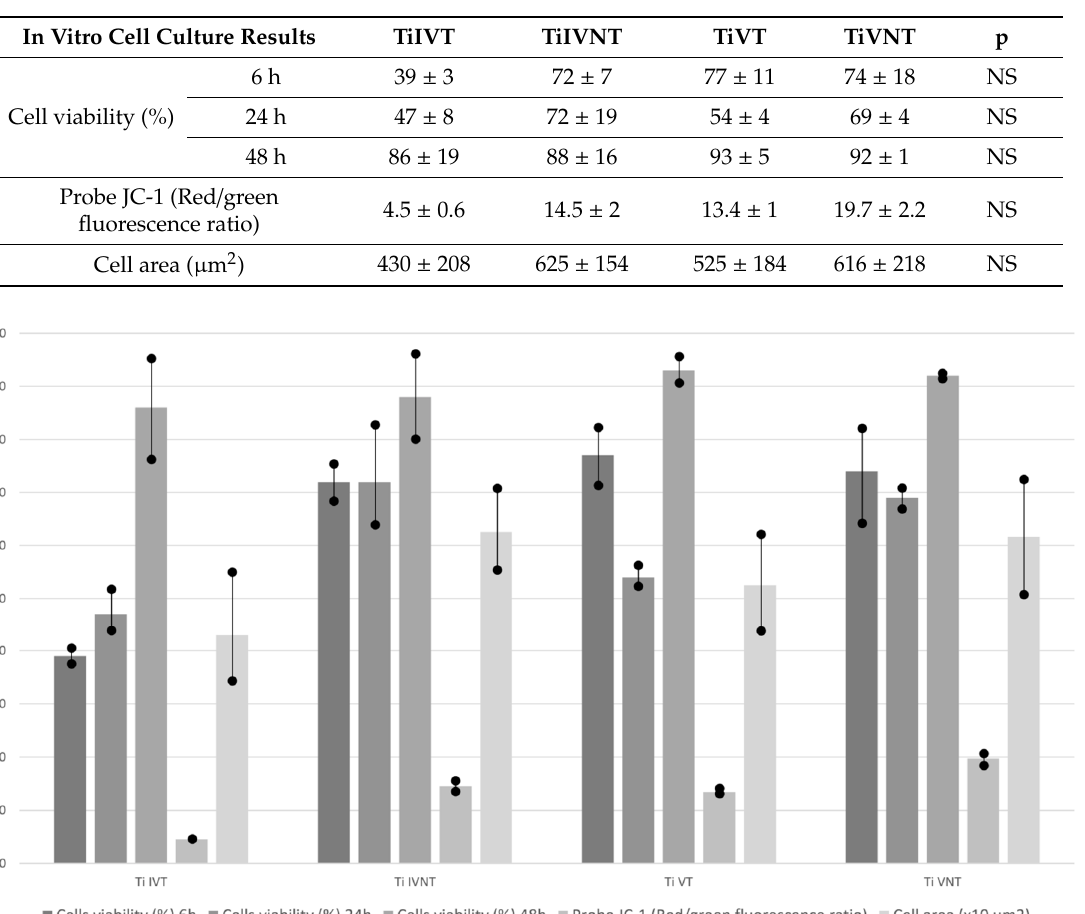
Figure 3. Cell cultures in vitro results.